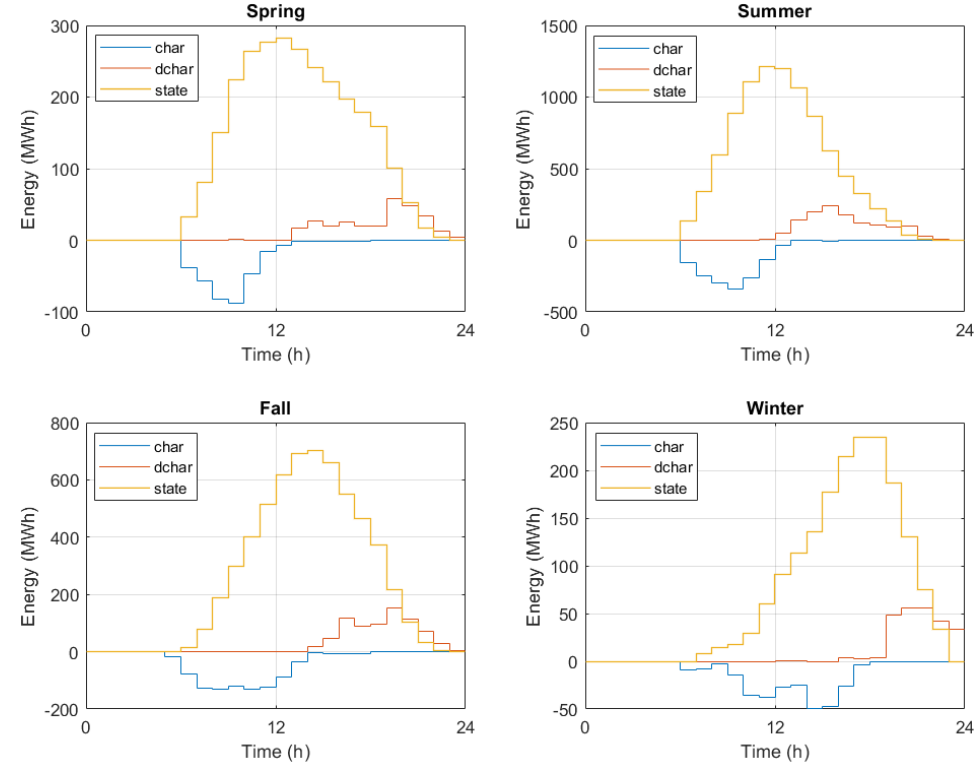
Figure 3. Charging/discharging operations and stored energy in the